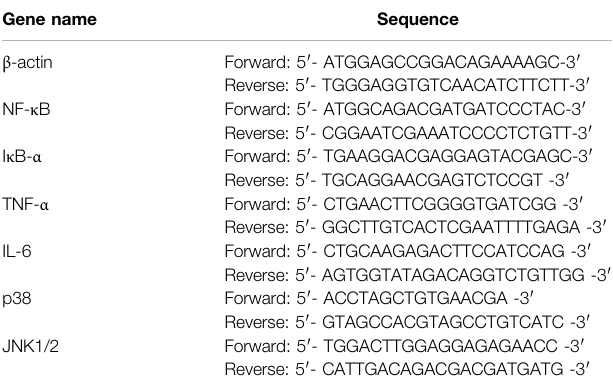
TABLE 1 | Sequences of primers used in the qPCR assay. Gene name